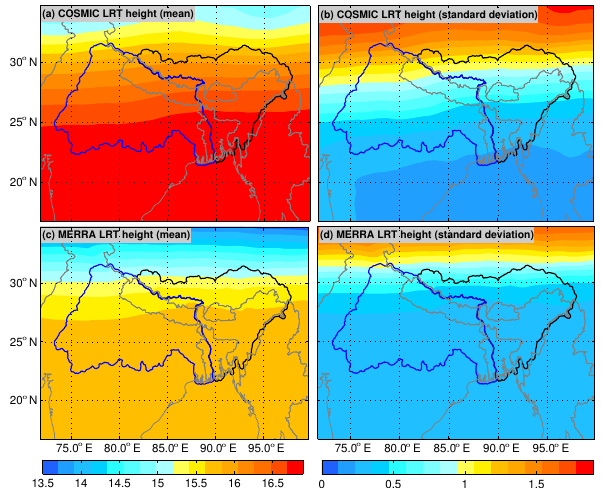
Figure 9. Spatial variation of mean and standard deviation of tropopause heights (km) derived from COSMIC RO and MERRA product based on 89 months from August 2006 to December 2013. (a) Mean and (b) standard deviation of tropopause heights (km) from COSMIC RO; (c) mean and (d) standard deviation of tropopause heights (km) from MERRA